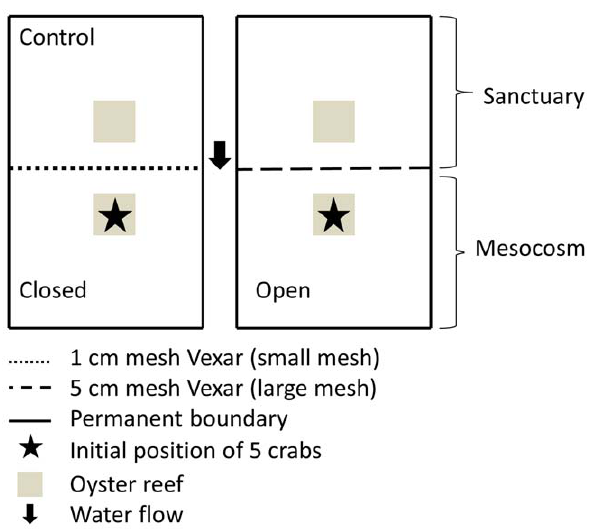
Figure 1. The experimental setup of the study showing open and closed mesocosms and the initial placement of mud crabs.